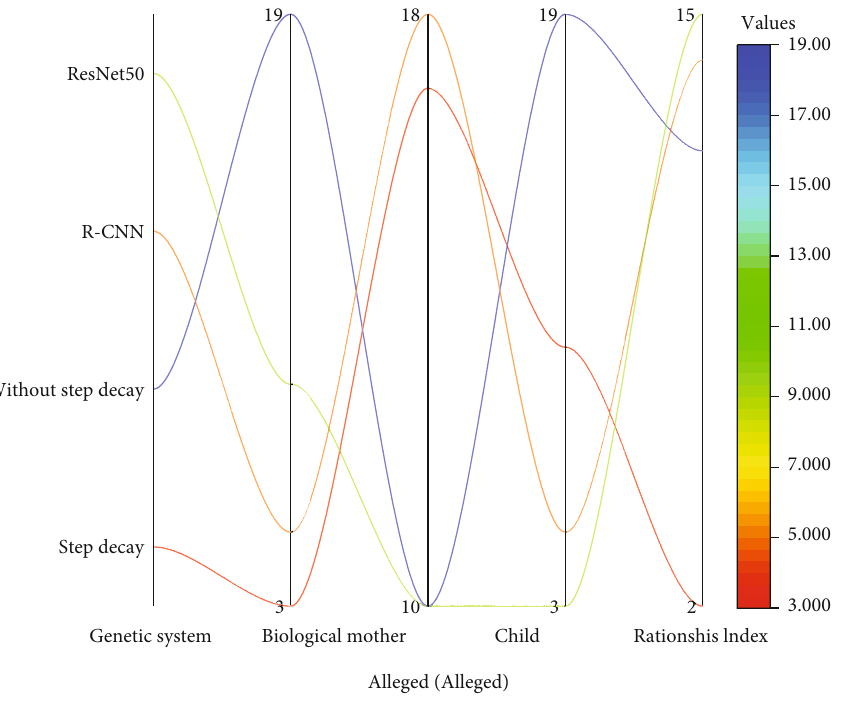
Figure 4: Semantic analysis